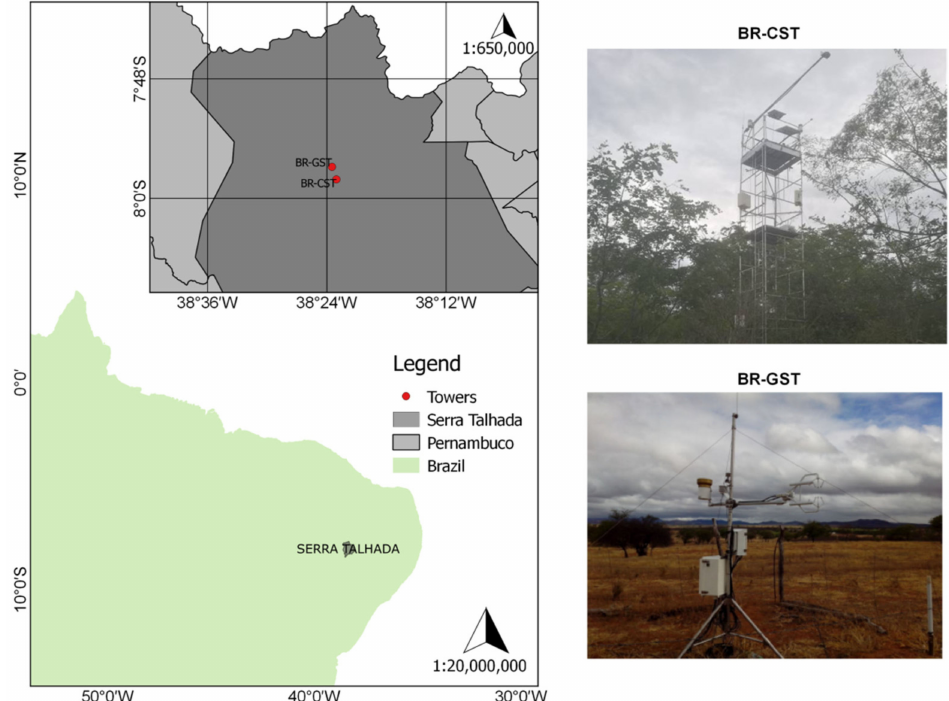
Figure 1. Location of NOWCDCB towers (BR-CST and BR-GST) in Serra Talhada, municipality of Pernambuco state (Brazil). The Caatinga area (BR-CST), with approximately 270 ha, is located in the Buenos Aires farm (7 ◦ 58 (cid:48) 5.20” S and 38 ◦ 23 (cid:48) 2.62” O, 430 m). There predominate Litolic Neosol